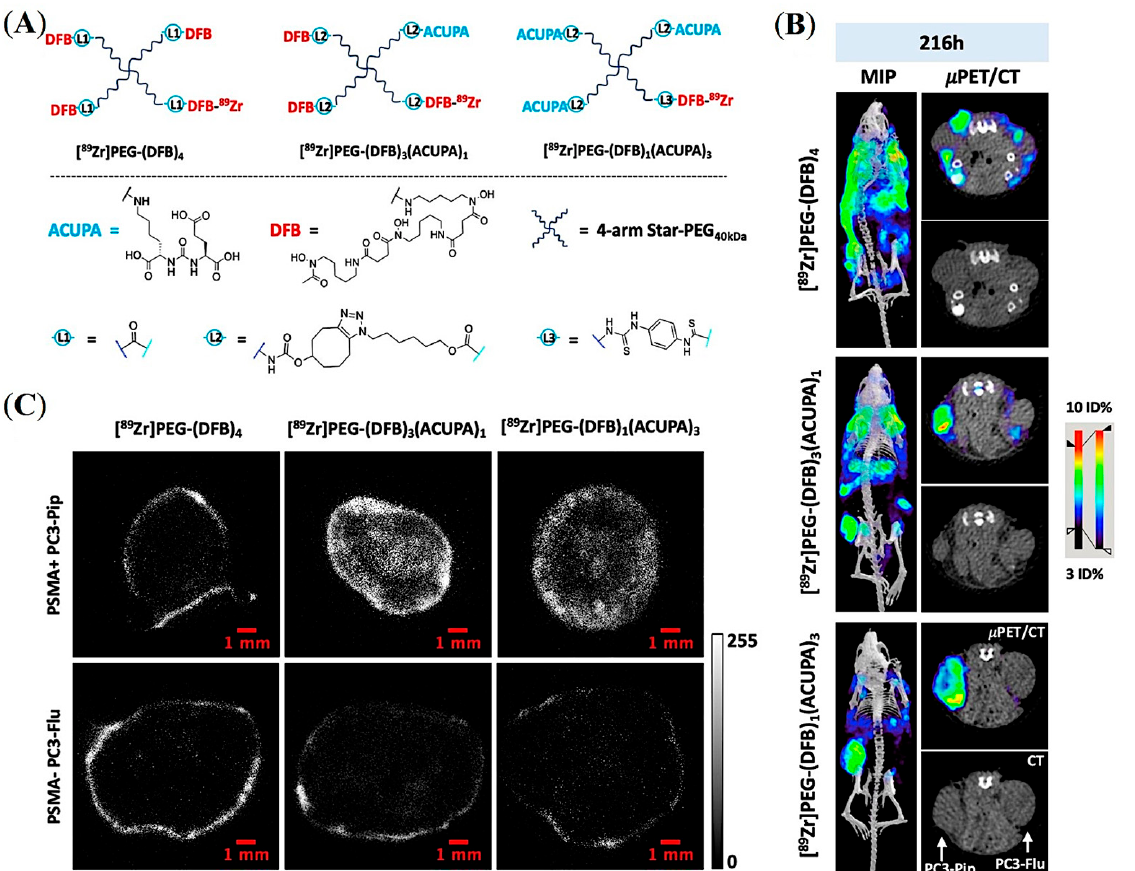
Figure 14. Development of PSMA-targeted starPEG nanocarriers for prostate cancer imaging. ( A ) Representative chemical structures of 89 Zr-labelled PEG nanocarriers without and with different